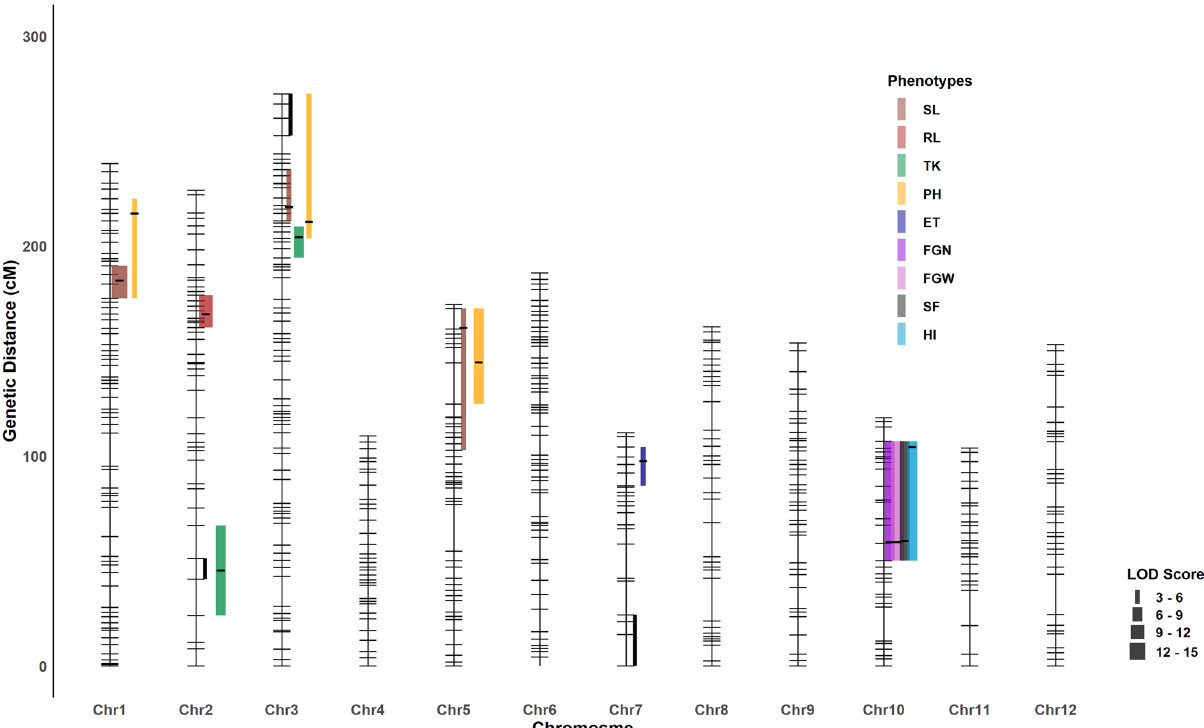
Figure 3. Illustration of QTL across chromosomes. QTL are denoted as a point and 1.5 LOD drop confidence intervals extended to a true marker is indicted by the bar for each QTL. Peaks of the QTL were marked as black line in QTL intervals. QTL from same trait are marked with same color. Line width represents the magnitude of LOD score. Genomic regions that showed significant association with cytoplasm are marked here with black line